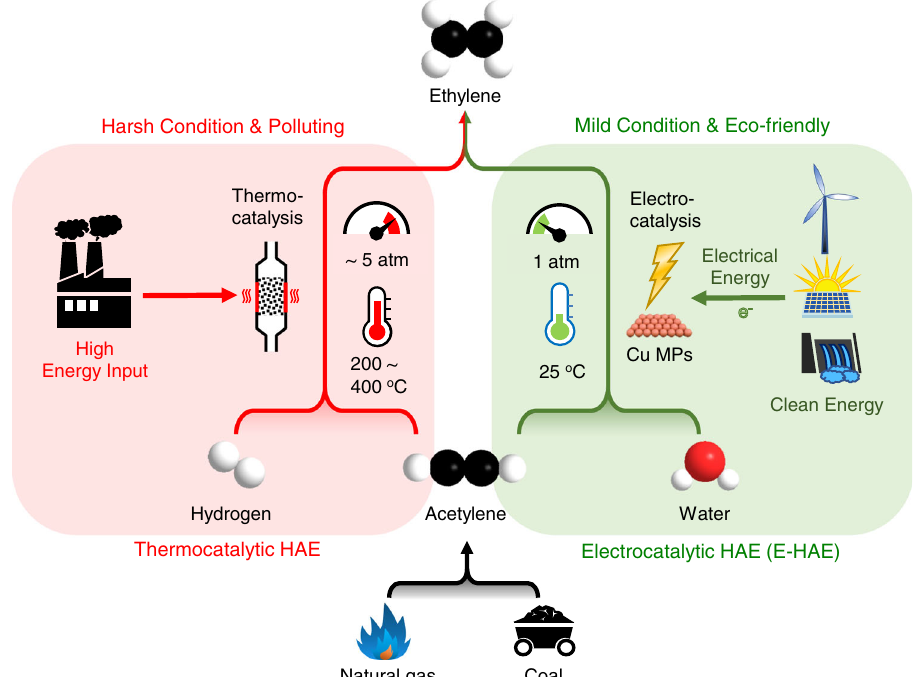
Fig. 1 The features of the electrocatalytic HAE (E-HAE) process compared with the traditional thermocatalytic HAE process. The E-HAE process is more economical and environmental-friendly, operatable under mild reaction conditions with inexpensive water as hydrogen source, in contrast to the thermocatalytic process, which requires harsh reaction conditions and an extra supply of H 2